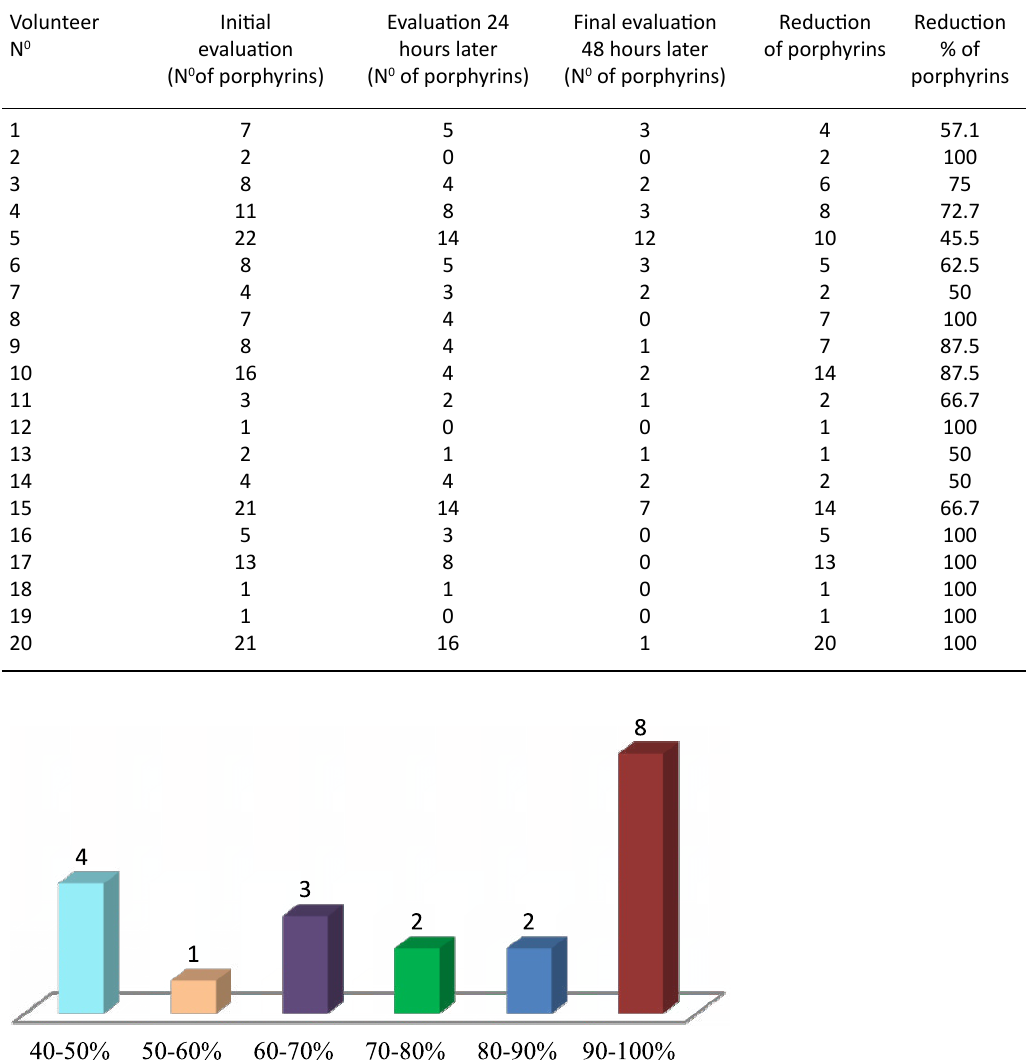
Table 5. Reduction percentage of porphyrins generated by P. acnes after the application of lotion A. Volunteer